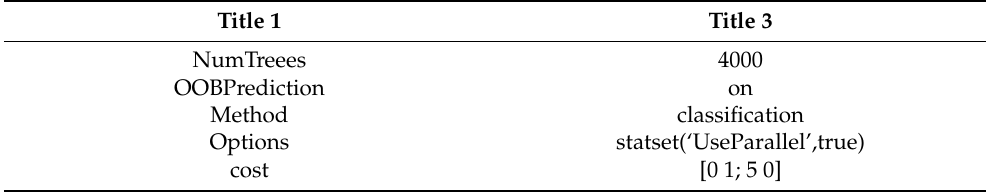
Table 3. The MATLAB TreeBagger classifier parameters used.